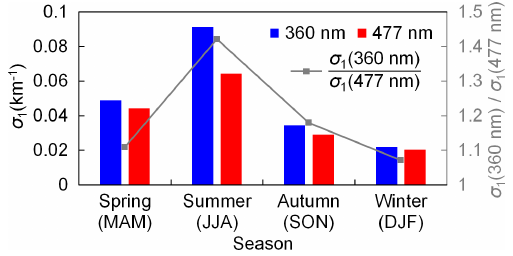
Figure 16. Comparison of seasonal average aerosol extinction co- efficients at 360 and 477nm in the bottom layer (0–0.5km above the instrument, σ 1 ). The colored bars show the average aerosol ex- tinction coefficients of the four seasons (equal to the bottom values shown in Fig. 15). The grey square markers indicate the ratios be- tween the aerosol extinction coefficients at 360 and 477nm.